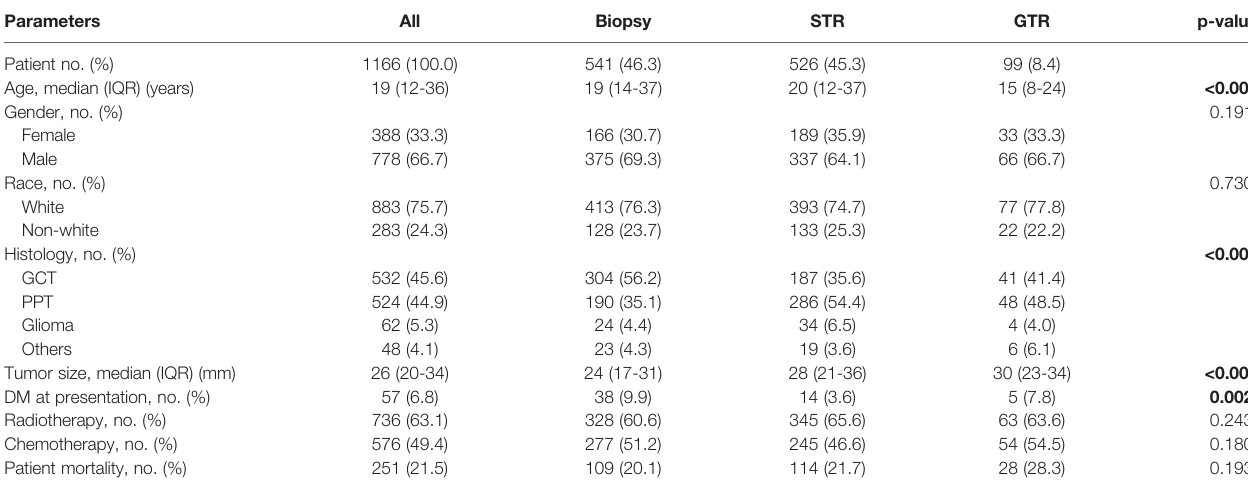
TABLE 1 | The associations of various parameters with the extent of resection. Parameters All Biopsy STR GTR p-value* Patient no.